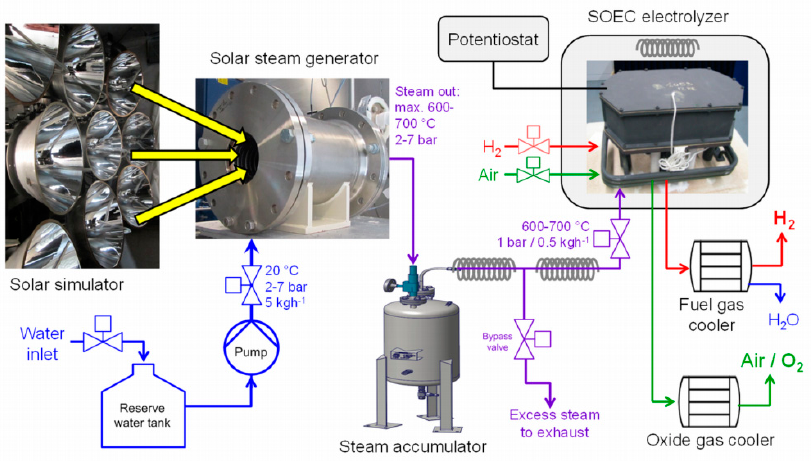
Figure 6. Schematic of the experimental system according to [6].